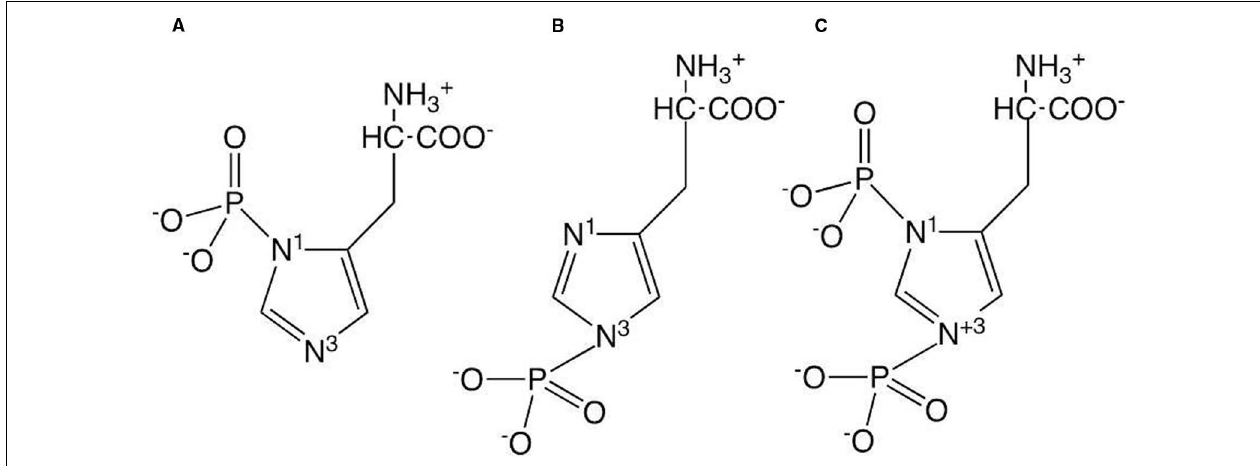
FIGURE 1 | Structures of the three forms of phosphohistidine: (A) 1-phosphohistidine; (B) 3-phosphohistidine; (C)